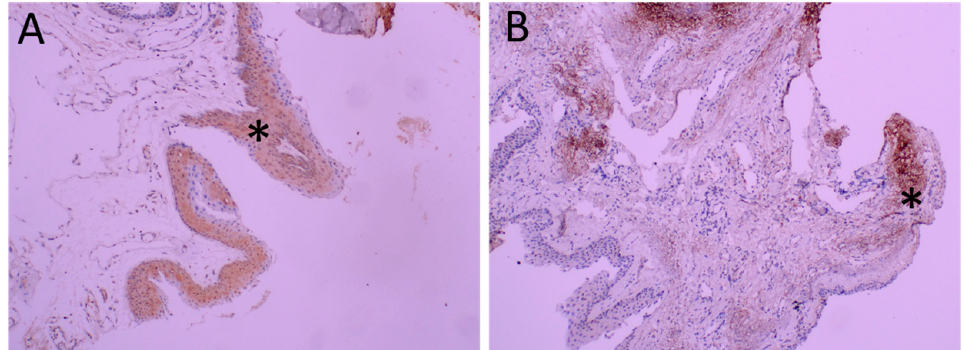
Figure 2. Immunohistochemical analysis of TRPV1 in pterygia. Representative figure of diffuse and intense staining of epithelium is seen in Panel ( A ) (*). Intense staining of stroma (*) is seen in Panel ( B ) at 200 magnification.